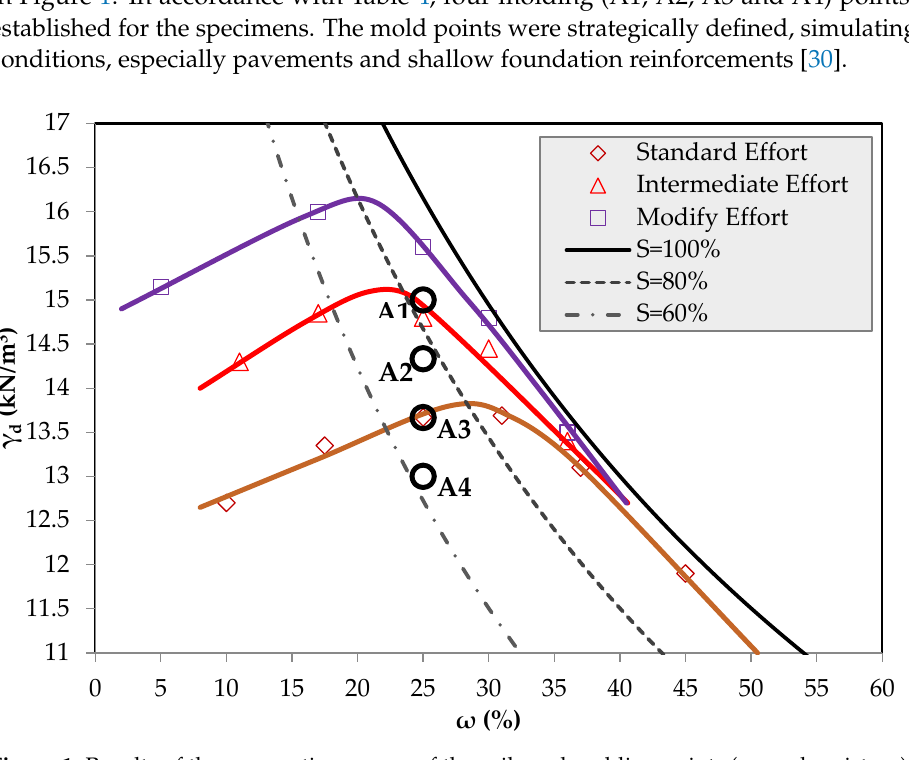
Figure 1 . Results of the compaction curves of the soils and molding points (γ d and moisture) . Figure 1. Results of the compaction curves of the soils and molding points ( γ d and